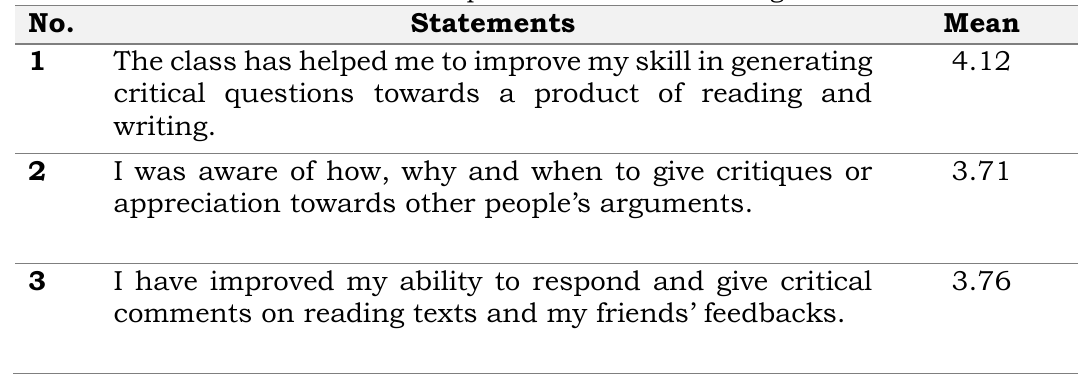
Table 1: Students’ perceived critical thinking